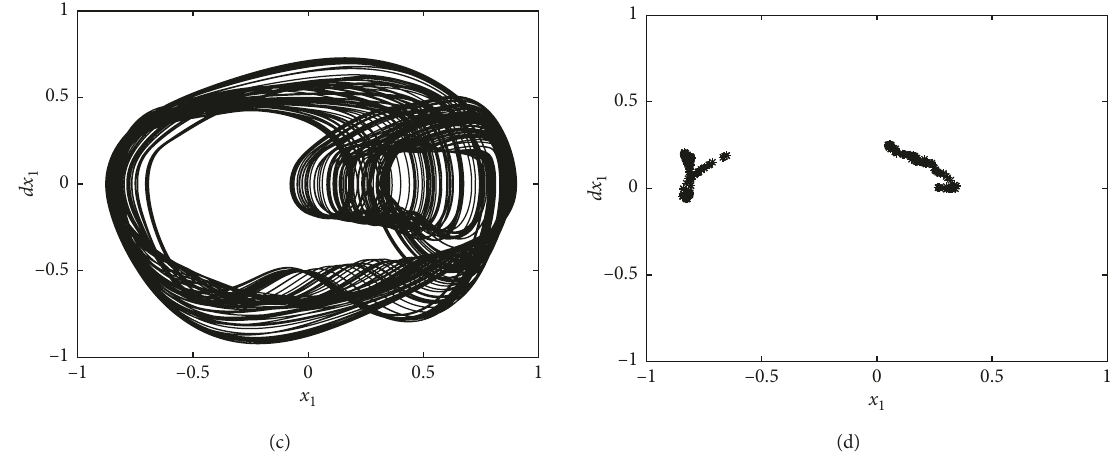
Figure 4: Response of the rotor system when ω � 750rad/s.